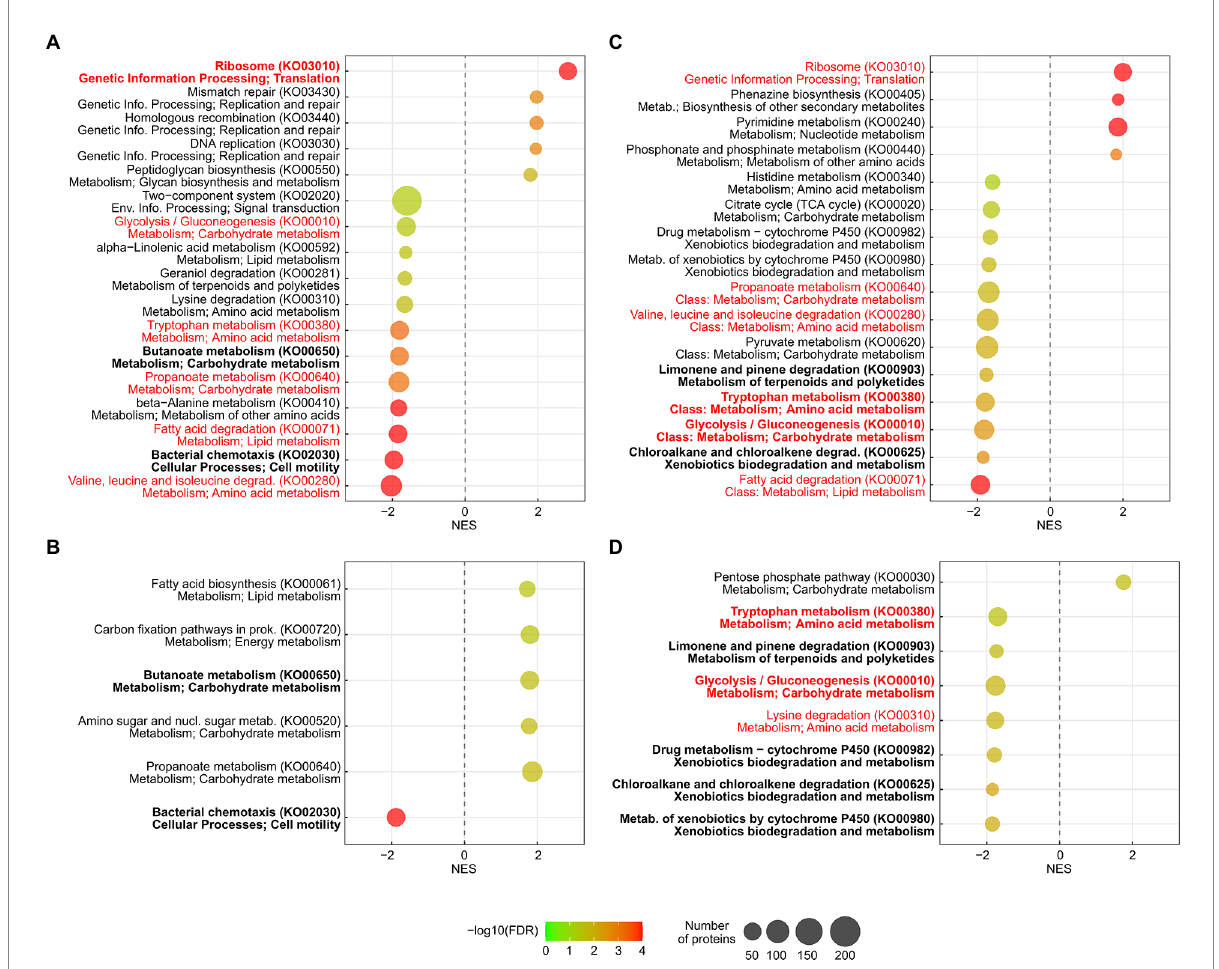
FIGURE 6 KEGG pathways that were significantly enriched when the strains were cultivated with the two highest sub-MICs of meropenem. Pseudomonas aeruginosa CCUG 51971 was cultivated with 256 μ g/ml (A) and 128 μ g/ml (B) . P. aeruginosa CCUG 70744 was cultivated with 8 μ g/ml (C) and 4 μ g/ml (D) . The row below each pathway indicates its class. In red: pathways enriched in both strains. In bold, pathways enriched in both conditions of one strain. FDR, false discovery rate; NES, normalized enrichment